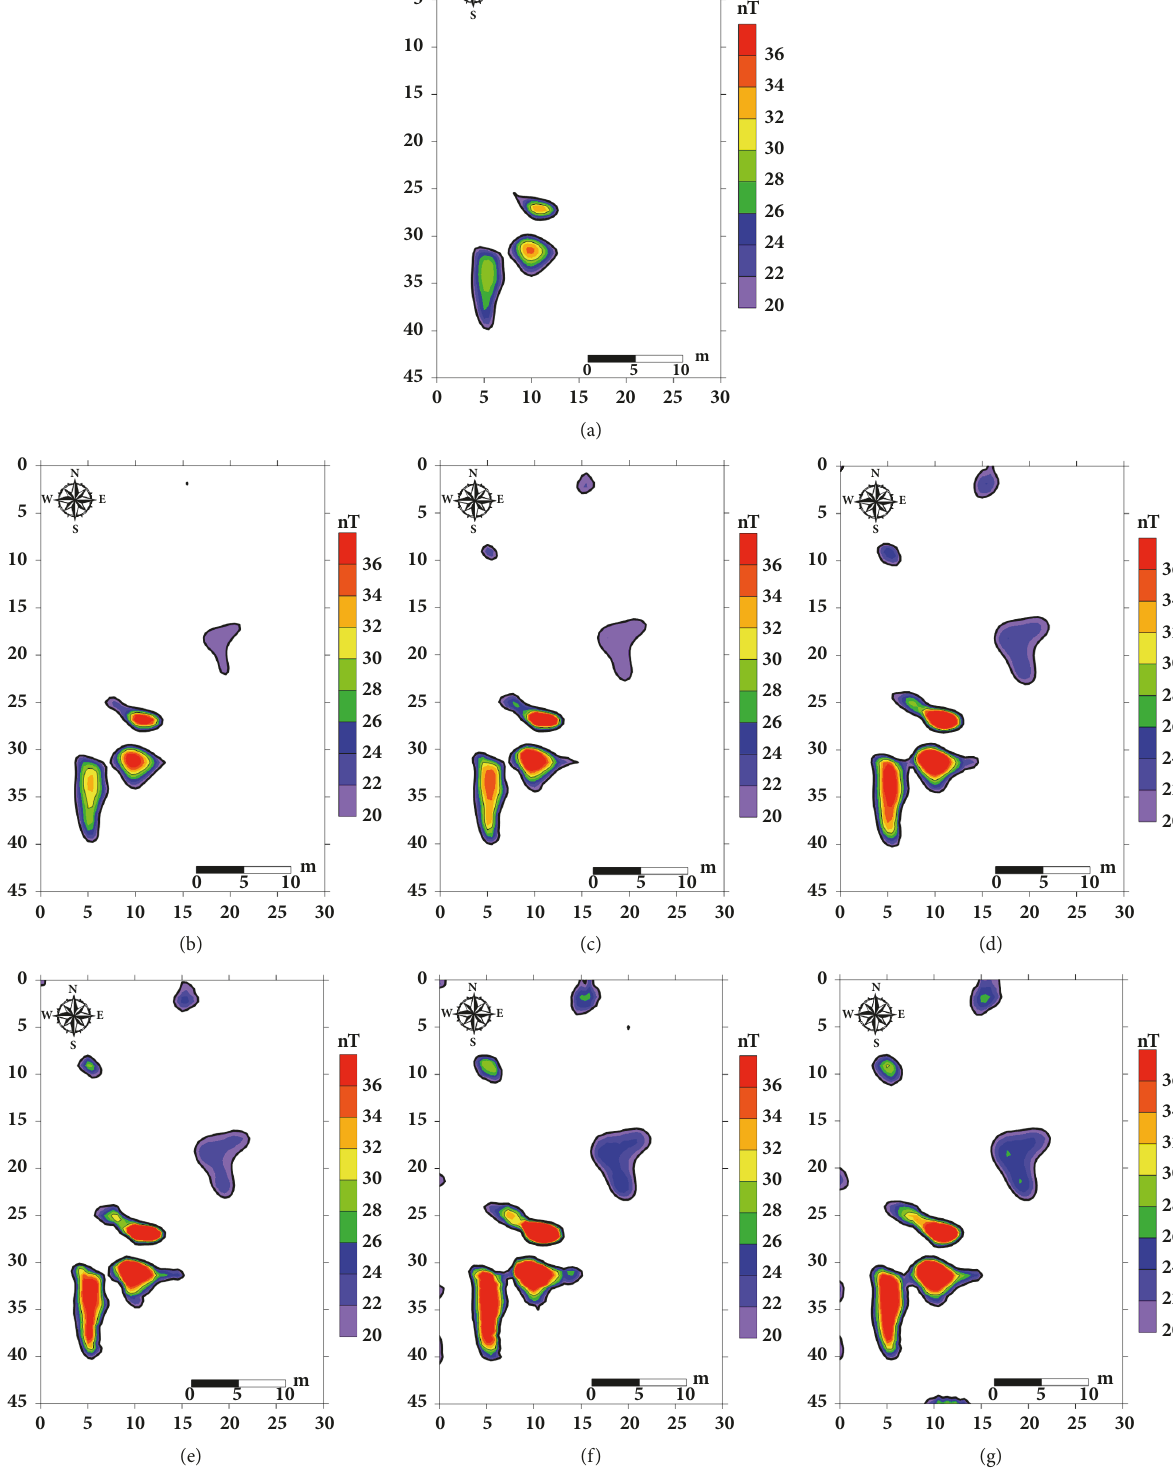
Figure 5: Downward continuation responses of the original magnetic data (contour interval = 2 nT). The original data (a) are downward continued to six different levels: (b) 0.2m; (c) 0.4m; (d) 0.6m; (e) 0.8m; (f) 1 m; (g)